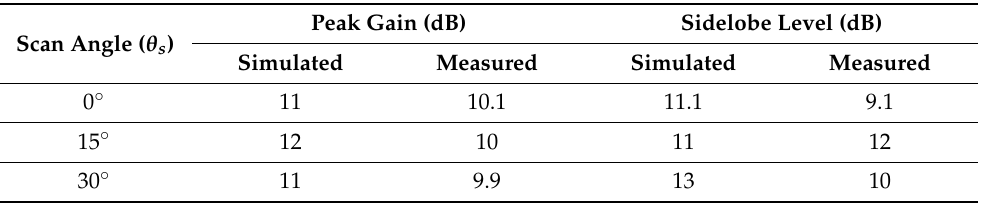
Table 4. Comparison between simulated and measured results of a 1 × 4 phased array with P-CRLH excited